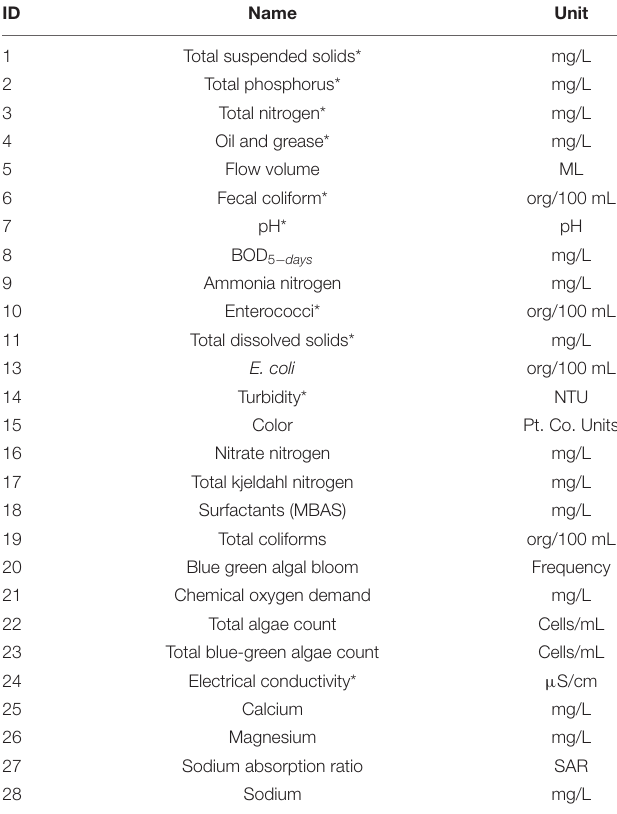
TABLE 1 | Water quality parameters recorded in the database with their assigned database ID and units of